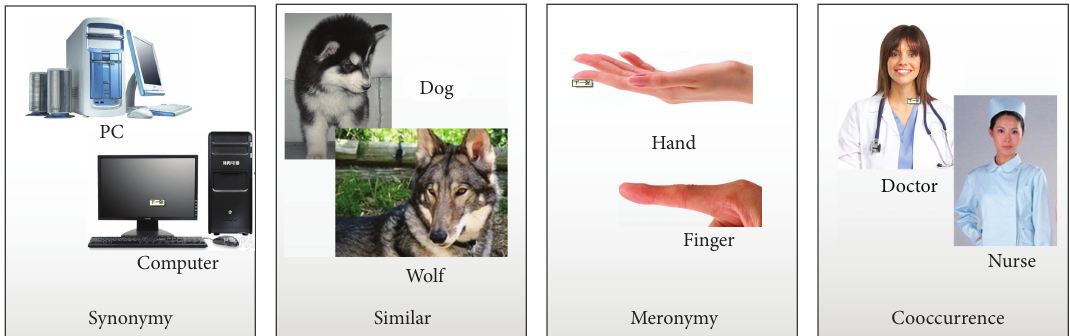
Figure 1: The illustration of four kinds of correlations between